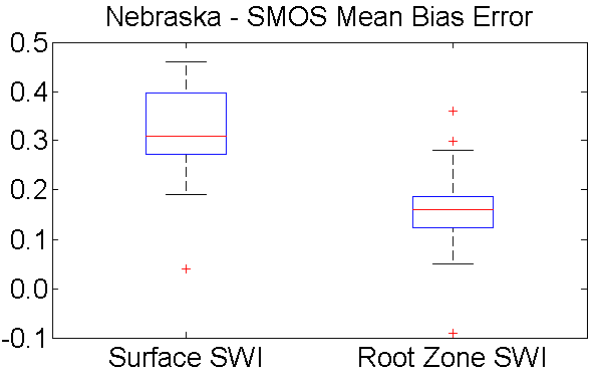
Figure 16 . Boxplots show mean bias error calculated from (left) surface SWI datasets and (right) Fig. 16. Box plots show mean bias error calculated from (left) sur- root zone SWI datasets. MBE is calculated between Nebraska stations and SMOS data. face SWI data sets and (right) root zone SWI data sets. MBE is calculated between Nebraska stations and SMOS data.